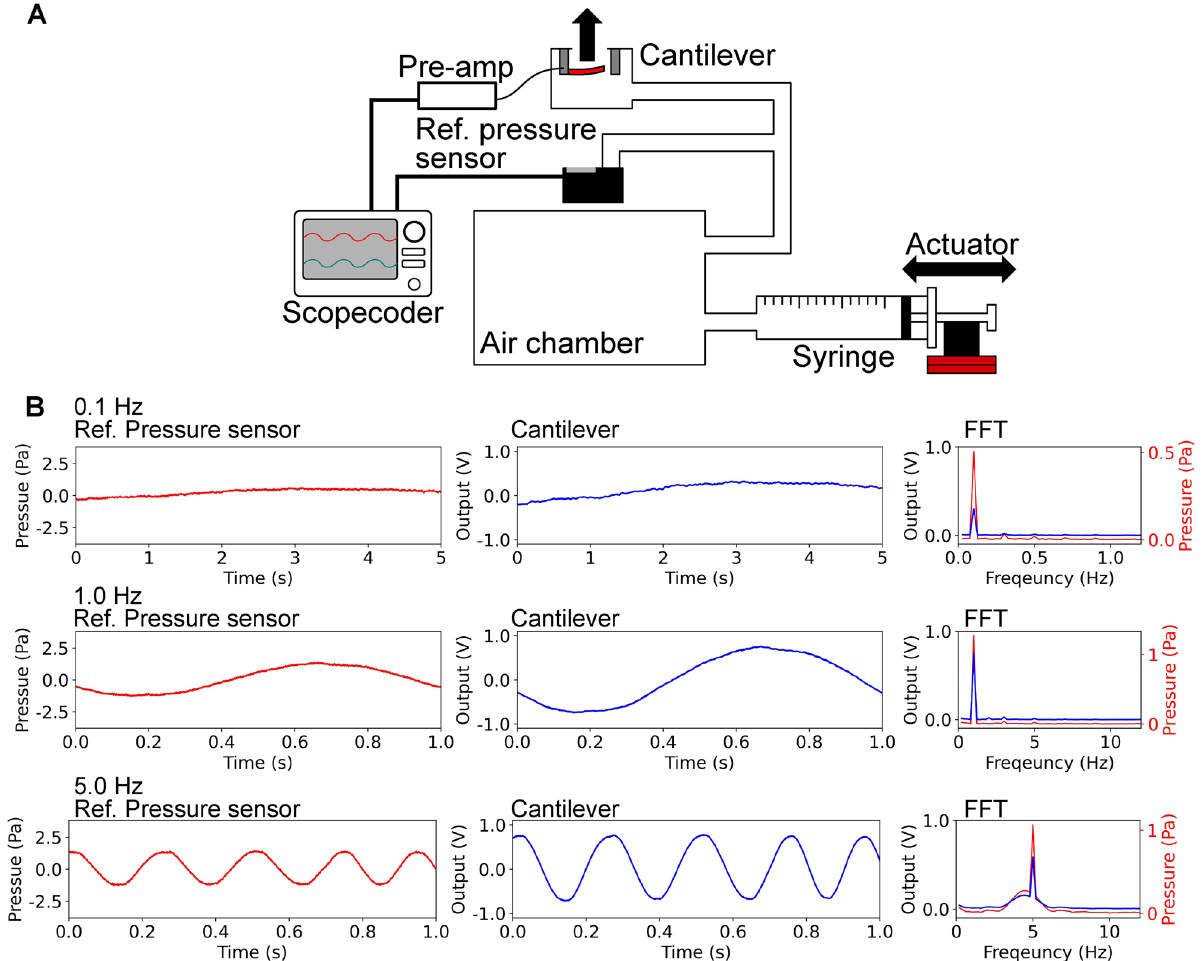
Figure 6. ( A ) Conceptual schematic of the experimental setup to evaluate the performance of the cantilever at low frequencies. ( B ) Timescale and frequency spectrum data of the measurement results of the reference pressure sensor and the proposed acoustic